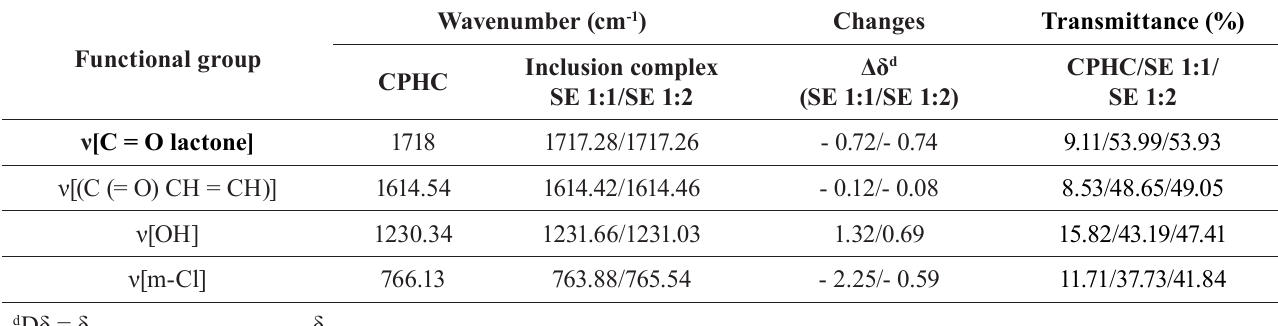
TABLE VI - Comparison between the intensity of FTIR signals of CPHC and the inclusion complexes prepared by solvent evaporation method